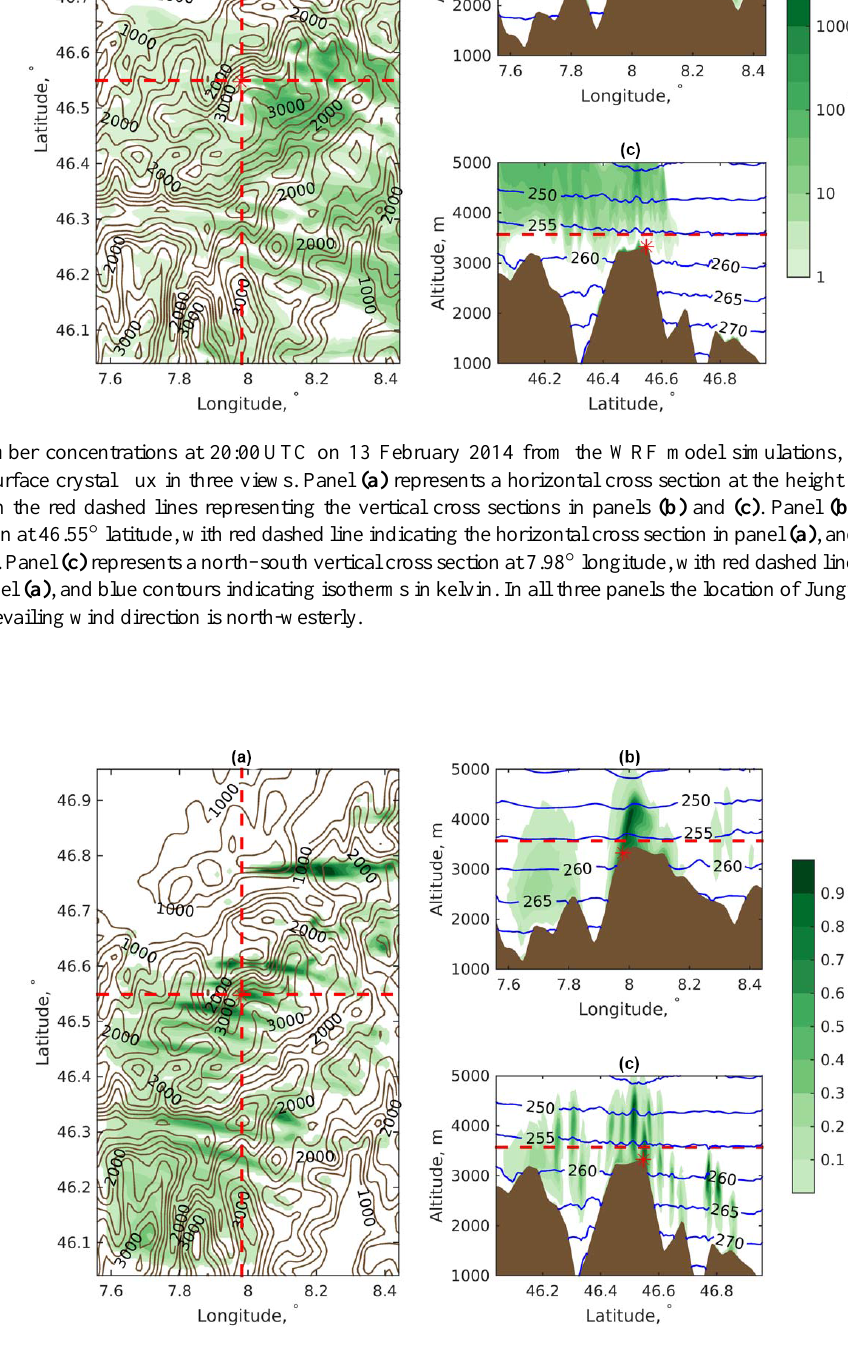
Figure 14. As Fig. 13 except for LWC at 20:00UTC on 13 February